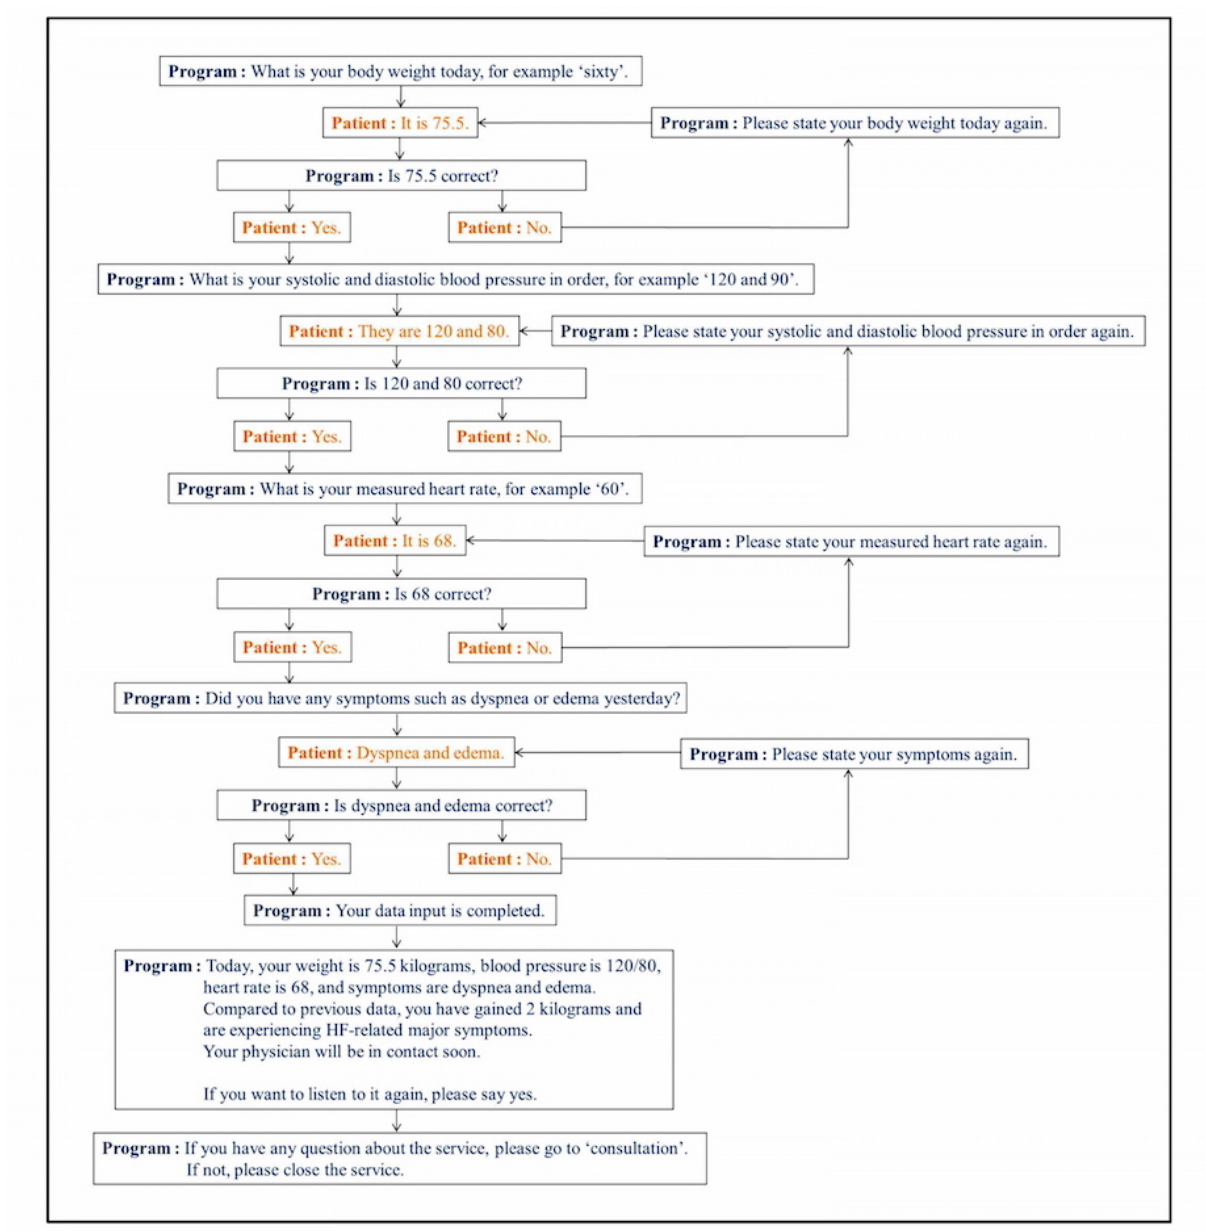
Figure 3. An example of flow diagram for voice recognition program. The voice recognition component of the automatic call and response system enabled the recognition of the patient’s voice data to be input into the ICT-based telehealth program. Patients were requested to speak a pre-set range of inputs, such as body weight, blood pressure, heart rate, and heart failure-related symptoms. Patients were guided by a series of pre-specified verbal questions and examples of possible answers. To ensure the accuracy of the obtained data, the program allowed patients to either confirm or correct the initial extracted